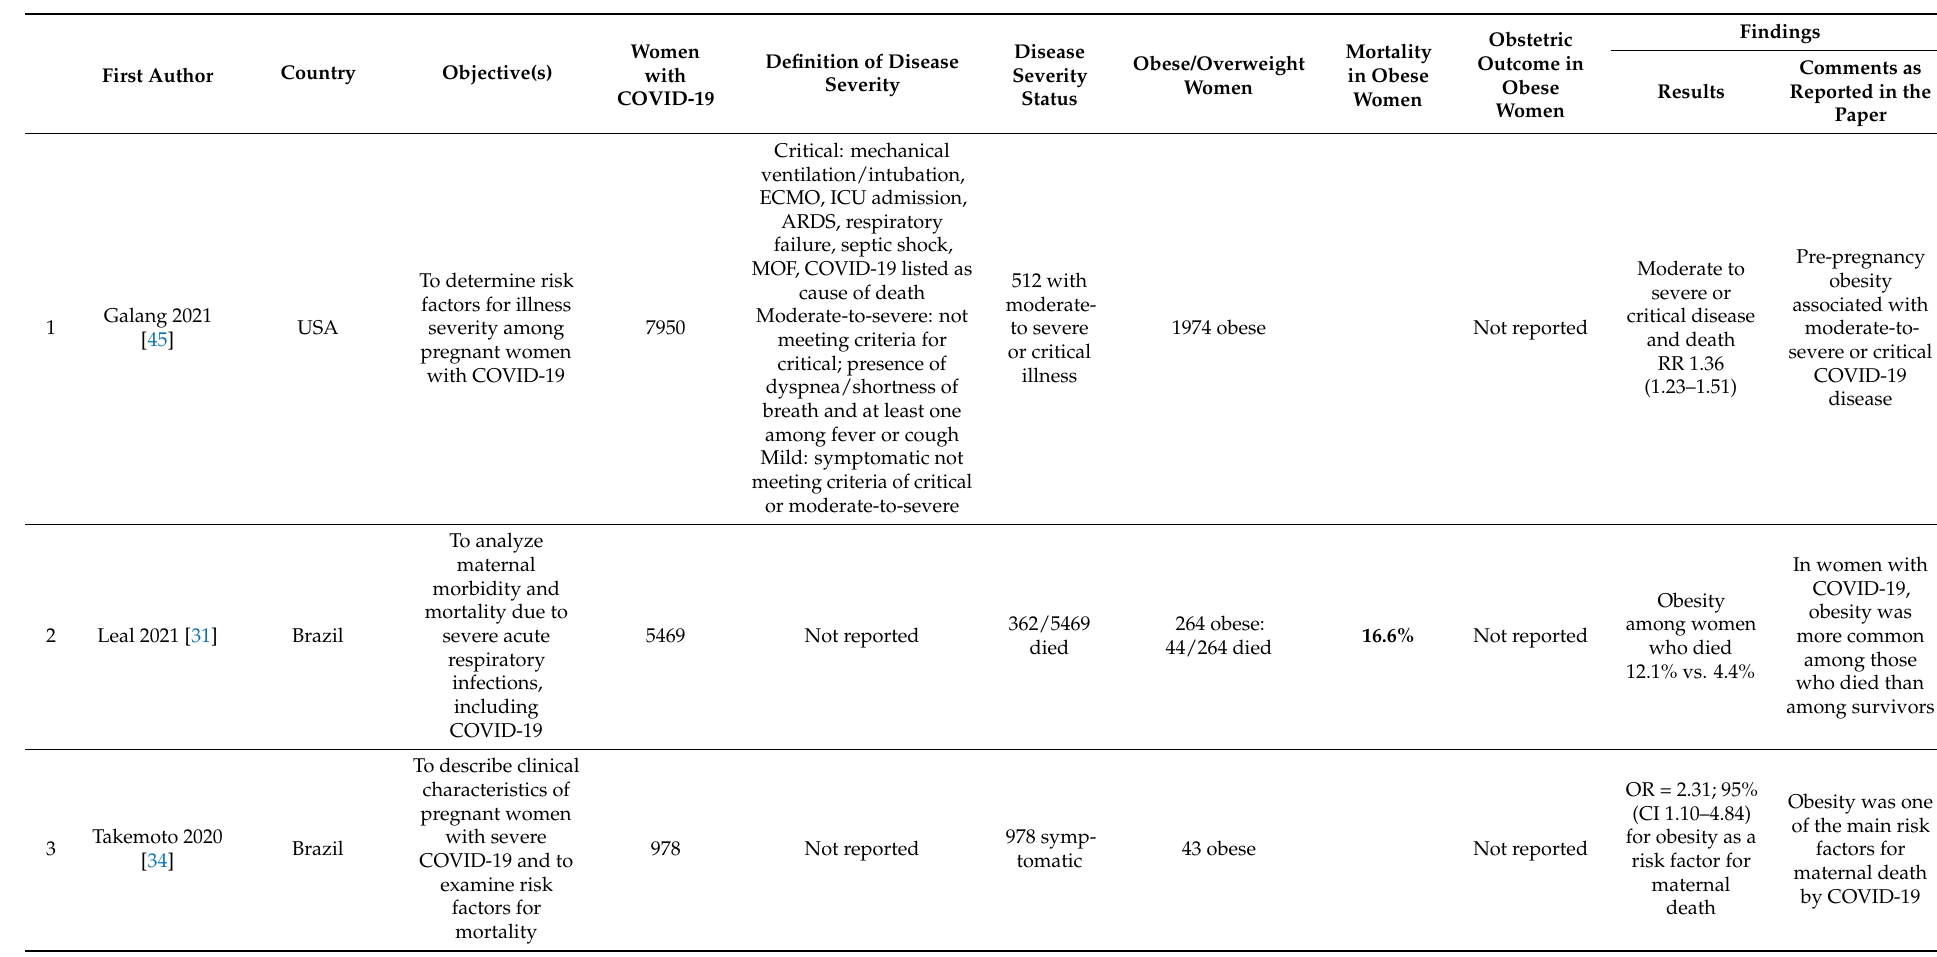
Table 2. Related maternal